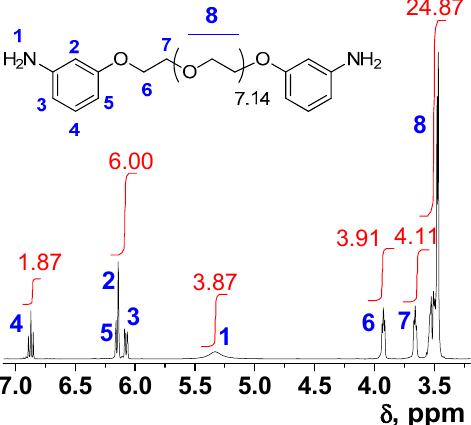
Figure 1. 1 H NMR of meta -oriented diamine 3b (in blue and red numbers the hydrogen assignation and the integrals, respectively).